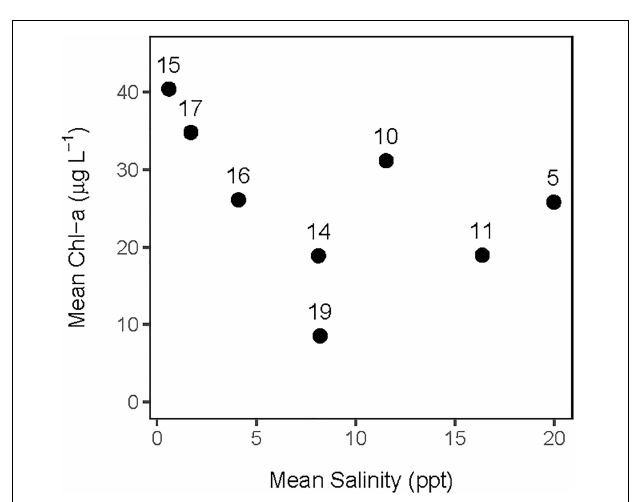
FIGURE 6 | Averaged annual values of daily salinity and chlorophyll-a concentration for each of the 8 polygons used in this analysis of the CASM calibration